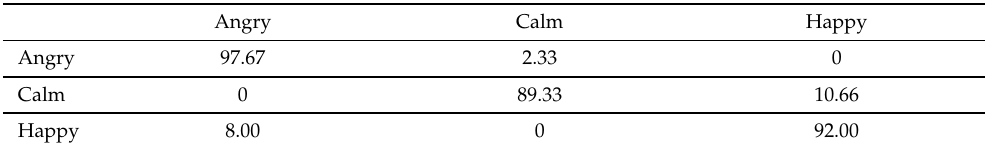
Table 5. Confusion matrix with the percentage of correctly classified samples after profile transfor- mation for each category (all test samples). Each sample has been transformed to the profile of each class and therefore each row sums up to